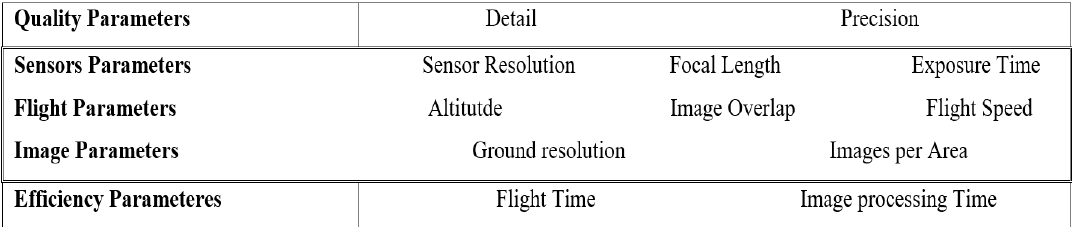
Figure 1. Different parameters in drone flights. The outer box represents the target variables, while the inner box shows the parameters that can be directly influenced by the mission planner and derivatives of those parameters.